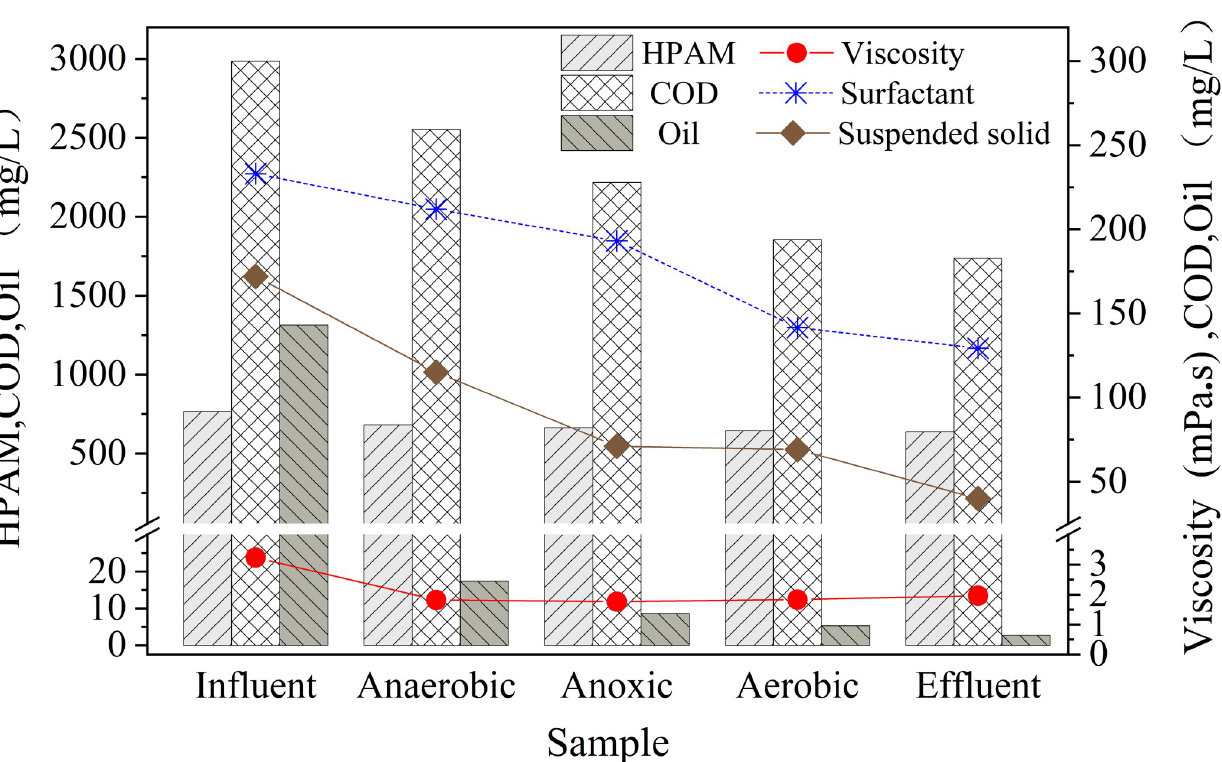
Fig 4. Mean values (90 d) of pollutants and associated parameters in different zones of the ABR.